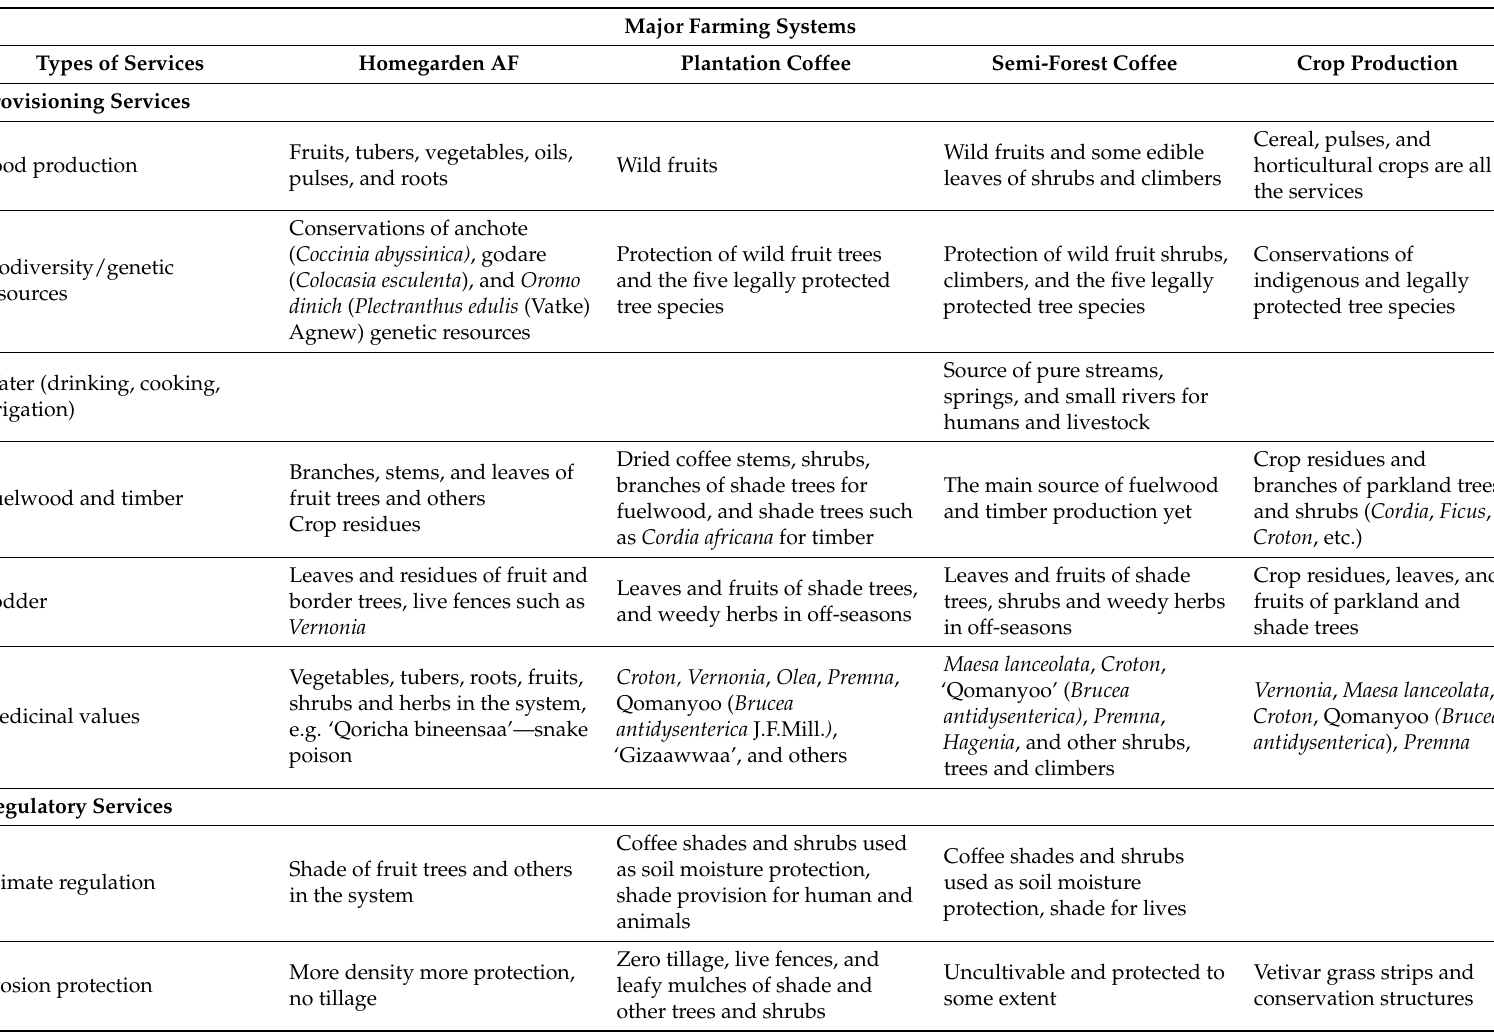
Table 2. Most important ecosystem services provided by the four major farming systems in the Yayo Biosphere